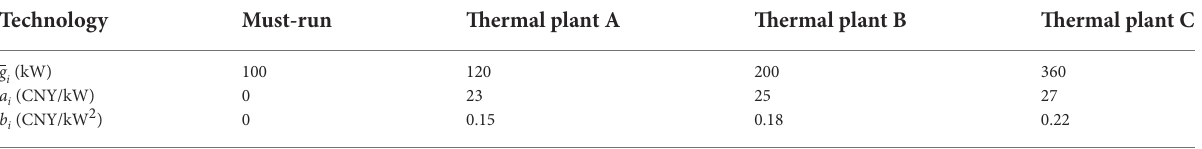
TABLE 2 Parameters of generation technology.